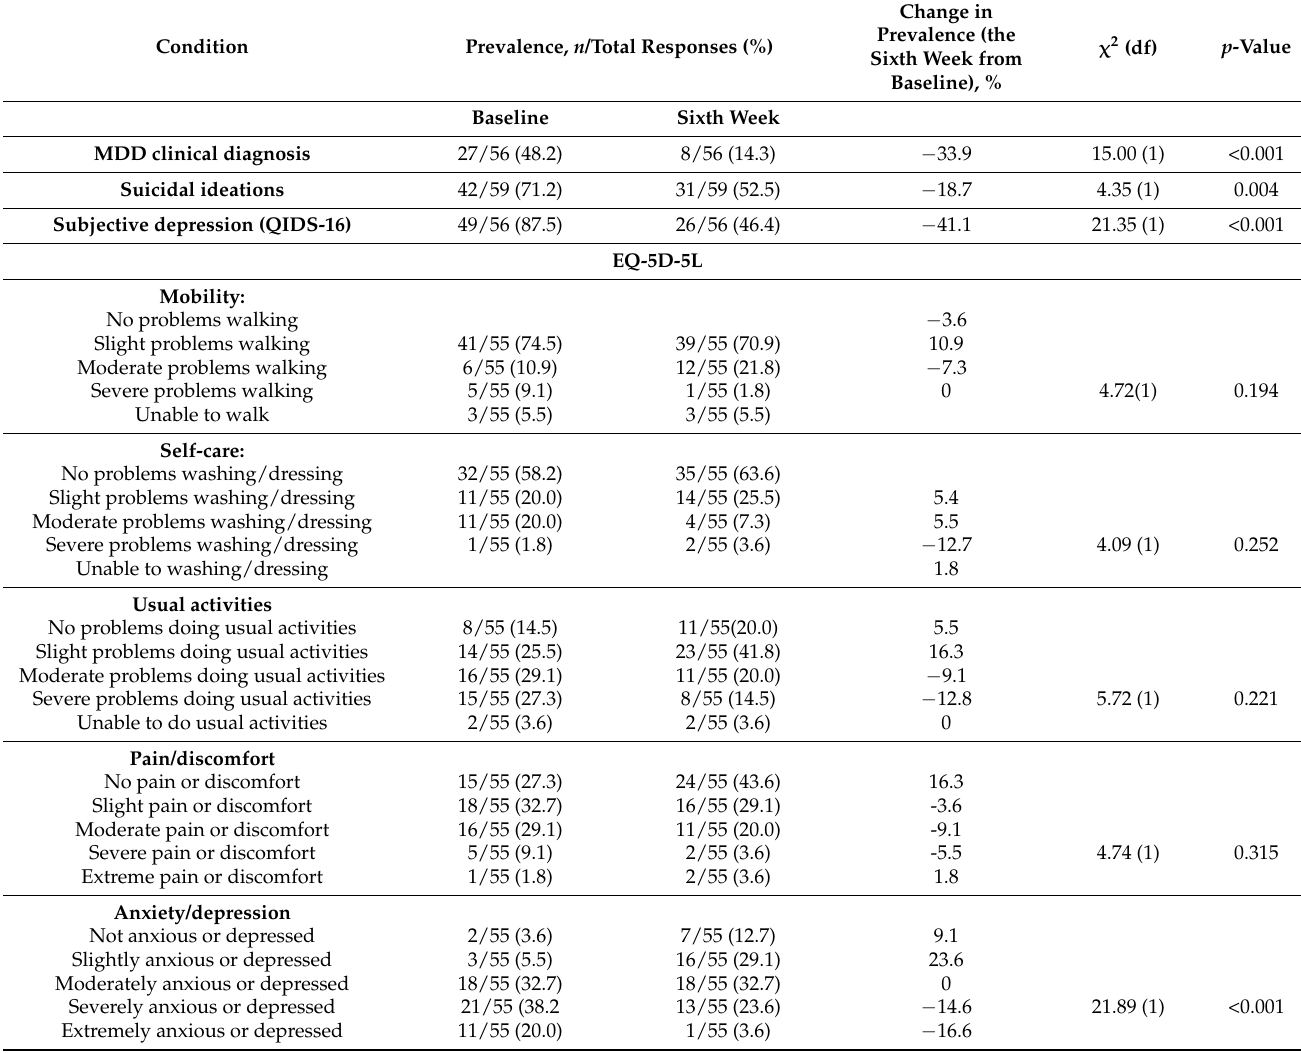
Table 5. Comparison of the baseline and 6-week prevalence of major depressive disorder, suicidal ideations, subjective depression, and the quality of health for all study